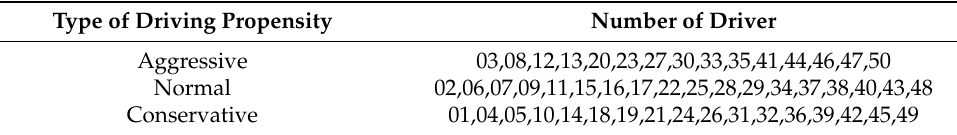
Table 7. Preliminary judgment result of driving